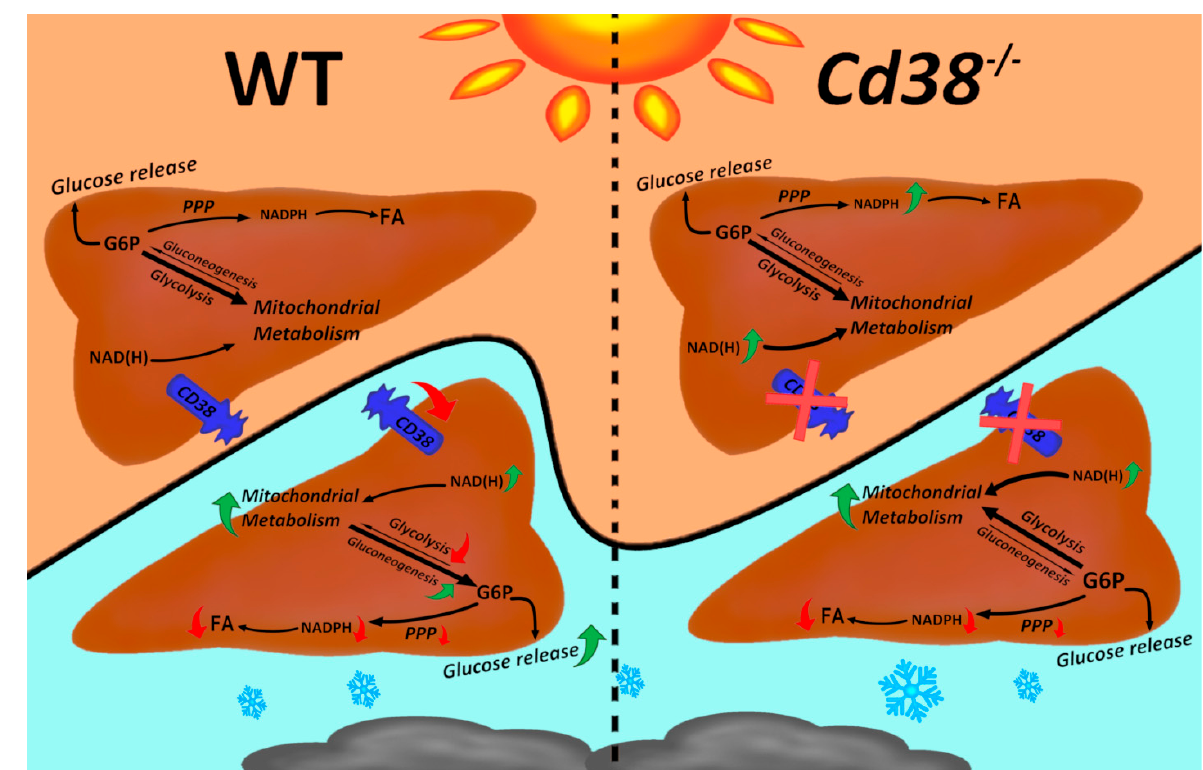
Figure 7. Scheme of cold-induced changes in liver from WT and Cd38 − / − mice. During cold exposure, CD38 expression is downregulated, and NAD(H) levels are increased. The pentose phosphate path- way (PPP) is downregulated, and NADPH levels are decreased, both in WT and Cd38 − / − mice, in agreement with a reduced fatty acid (FA) synthesis. The glycolytic pathway is also downregulated in WT mice, re-directing glucose-6-P (G6P) towards glucose release. Conversely, glycolysis is not downregulated in Cd38 − / − mice, indicating that CD38 is important for the glycolysis/gluconeogenesis cross-regulation. Sirtuin 3 activity, controlling mitochondrial metabolism, is enhanced by cold ex- posure in liver of WT mice, whereas it is upregulated in Cd38 − / − mice, regardless of the temperature.